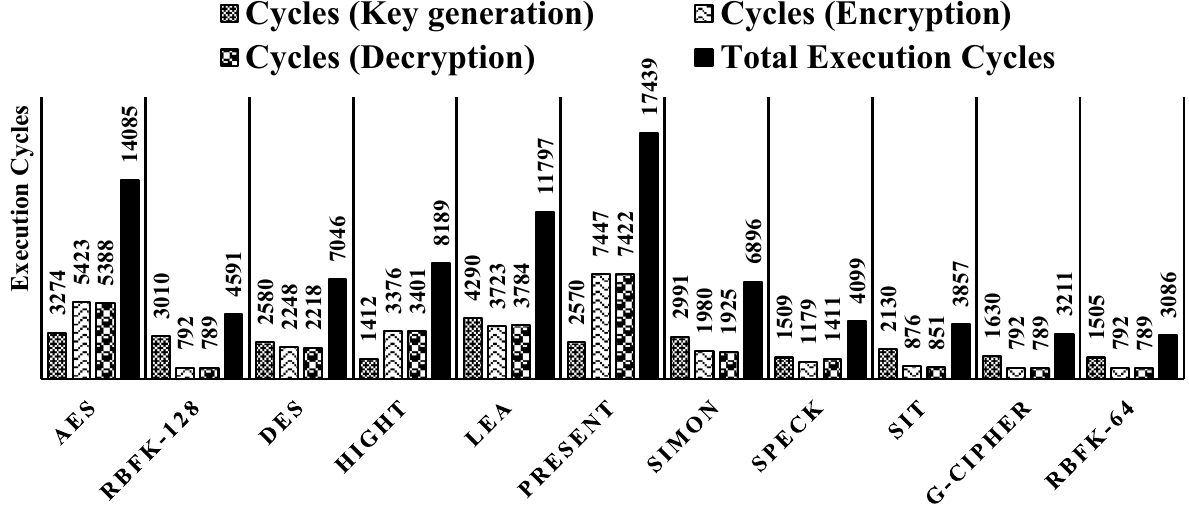
Fig. 11 Execution cycle of one block data for different